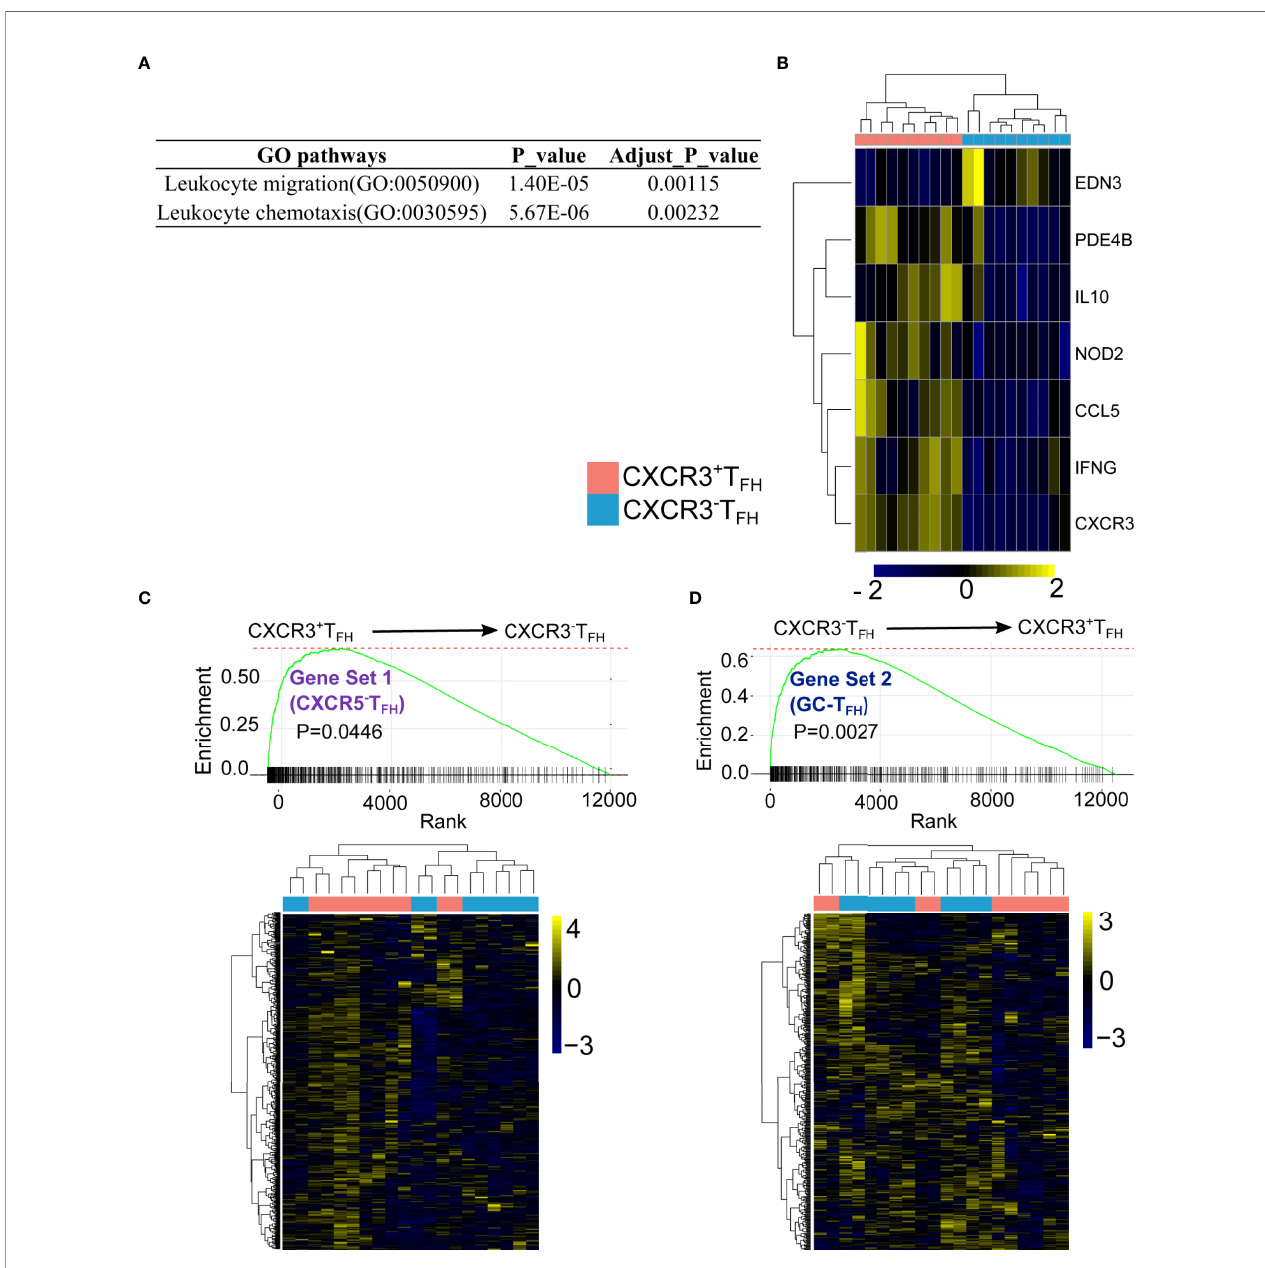
FIGURE 3 | CXCR3 + T FH uniquely express cell migratory genes and transcriptomic-ally similar with CXCR5 - T FH . DEGs between CXCR3 + T FH and CXCR3 - T FH were enriched on T cell migration pathways (A) with migratory genes upregulated in CXCR3 + T FH (Leukocyte chemotaxis, GO:0030595) (B) GSEA analysis indicates genes elevated in CXCR5 - T FH (Gene set 1) were upregulated in CXCR3 + T FH (C) while genes upregulated in GC-T FH (Gene set 2) were also elevated in CXCR3 - T FH (D) GSEA were performed with R package ‘ fgsea ’ , speci fi cally, genes were pre-ranked by their p-values, which indicates whether one gene is highly expressed in CXCR3 + T FH or CXCR3 - T FH . The bar on the X-axis indicates one gene from a selected gene set (i.e., either Gene set 1 or Gene set 2). The curve is a running sum of the bars on the